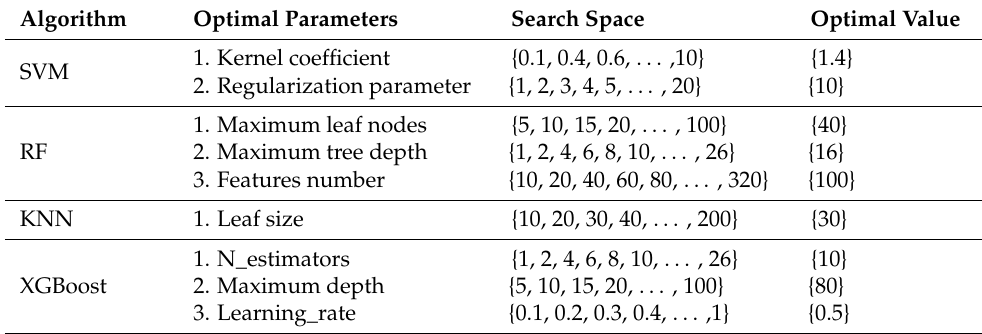
Table 4. Hyper-parameters optimization of different methods.